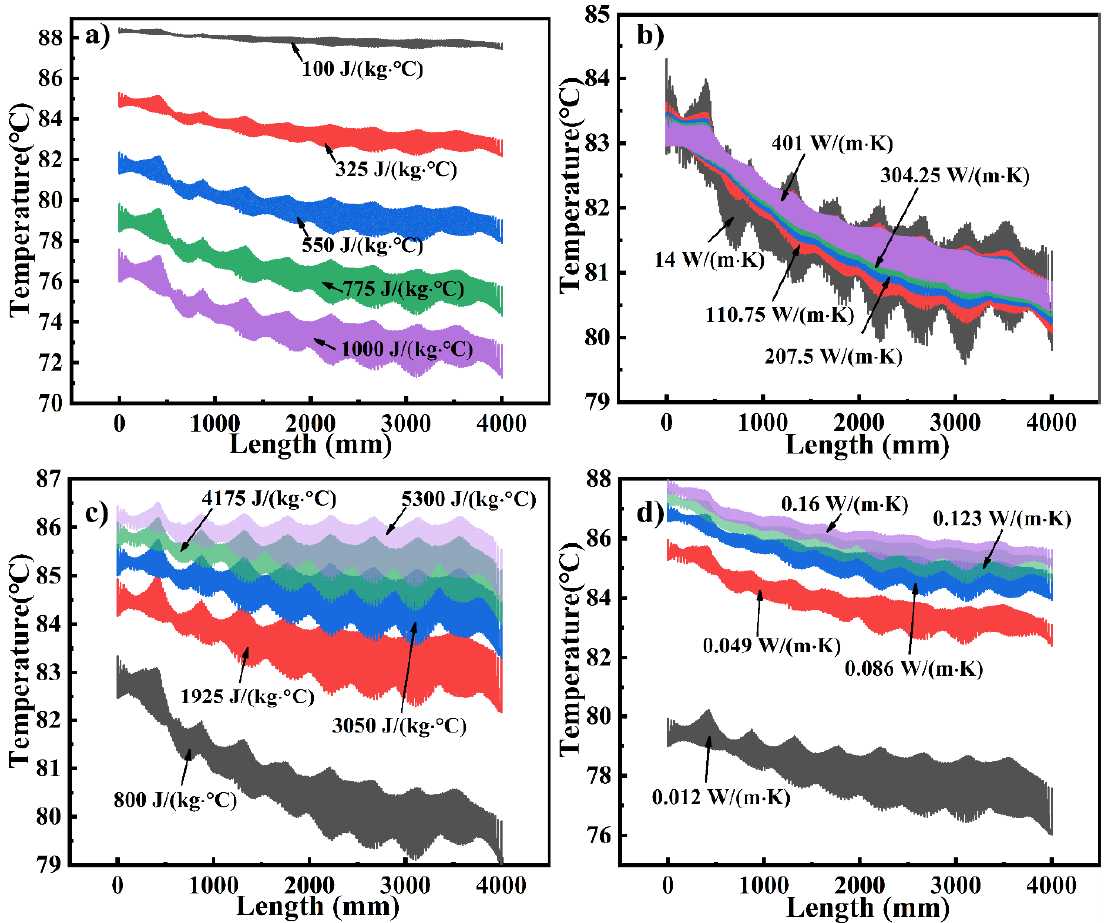
Figure 14. Temperature distribution projection as a function of ( a ) specific heat of the mold, ( b ) thermal conductivity of the mold, ( c ) specific heat of the fluid, and ( d ) thermal conductivity of the fluid.